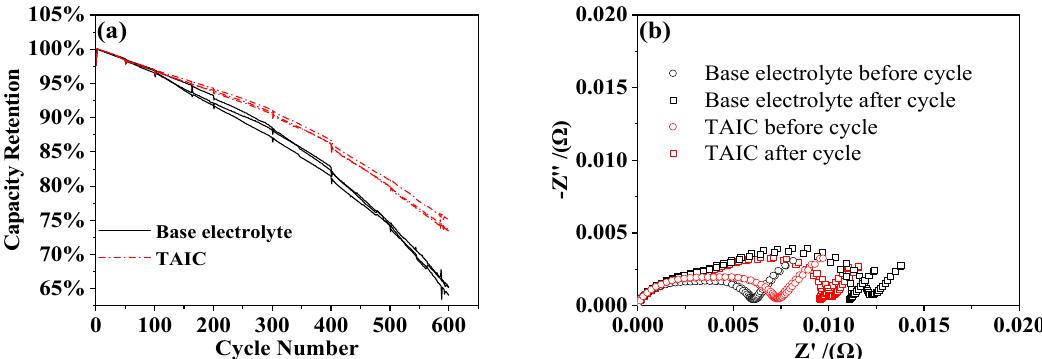
Figure 5. Cycle performance of full-cell at charge/discharge rate of 1 ◦ C at 45 ◦ C: ( a ) Capacity retention rate; ( b ) EIS Nyquist plots of LiCoO 2 vs. Li + /Li EIS with a different electrolyte before and after the cycle.